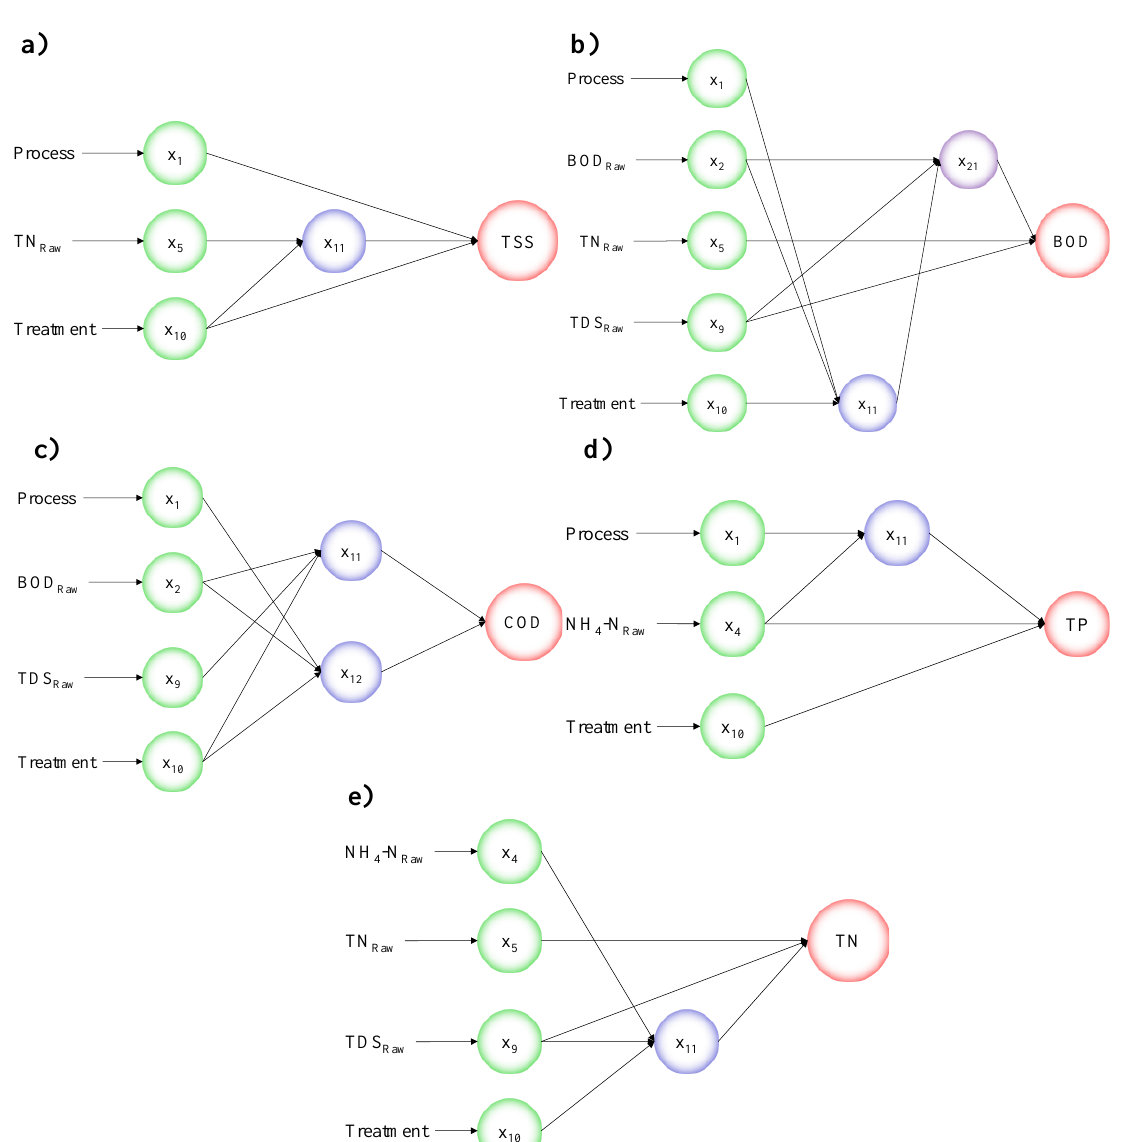
Figure 3. Structure of the developed GSGMDH models: ( a ) TSS; ( b ) BOD; ( c ) COD); ( d ) TP; and ( e ) TN.